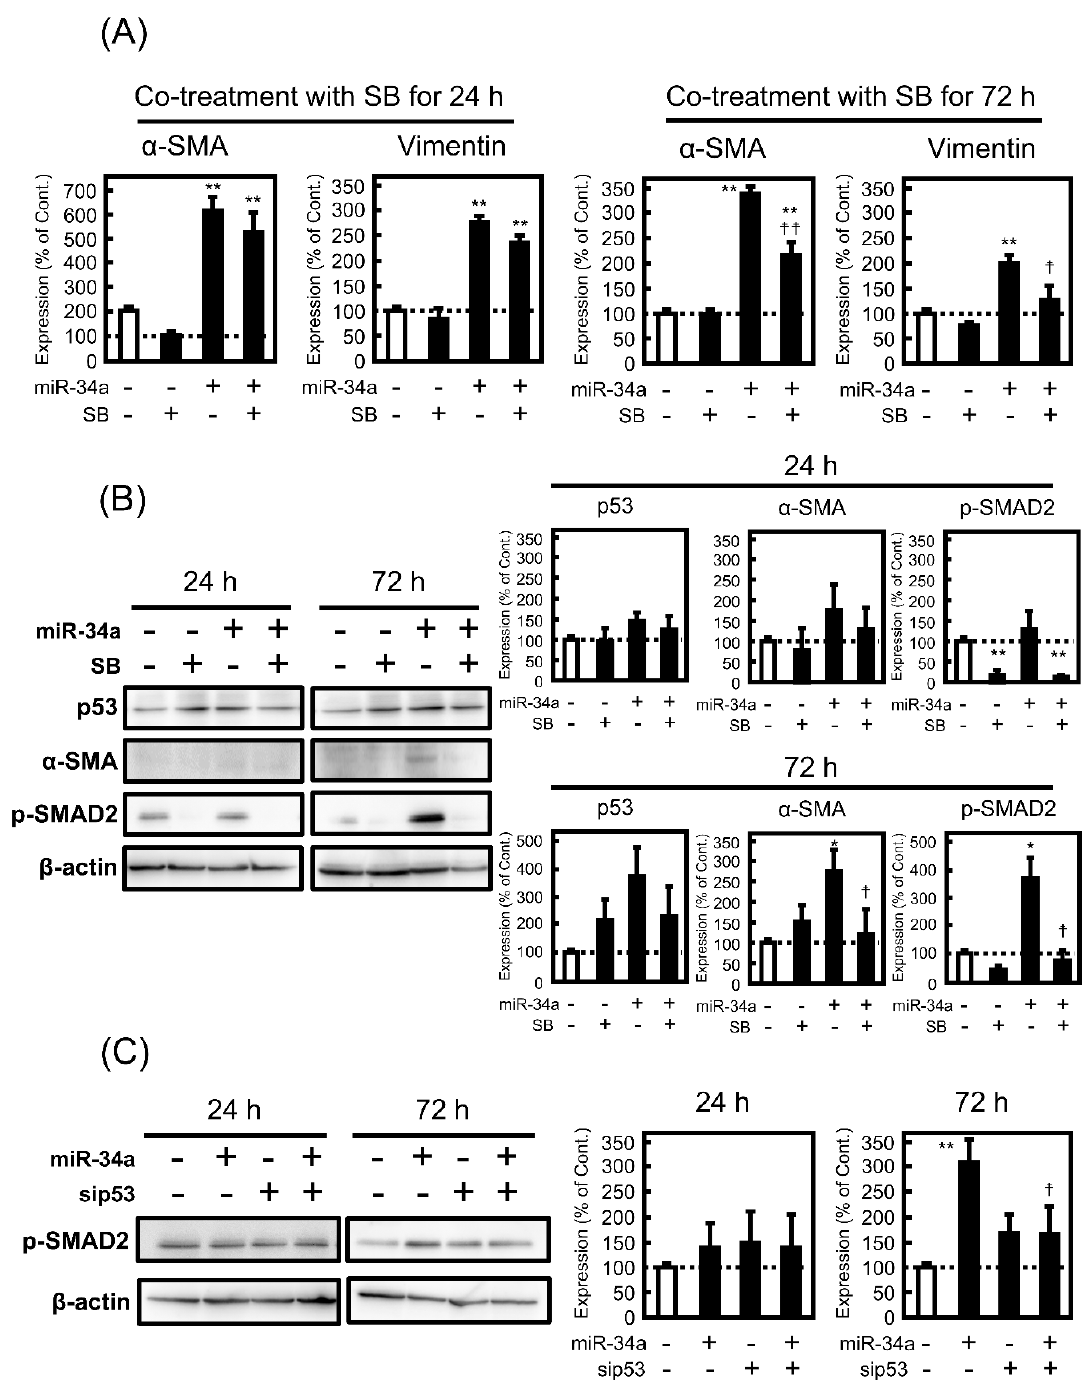
Figure 6. Role of the transforming growth factor (TGF)-β/SMAD signaling in miR-34a-induced changes in EMT-related phenotypes in A549 cells. The cells were transfected with NC (20 pmol/well) or miR-34a mimic (20 pmol/well) for 24 h. After removal of the medium containing the miRNA mimic, the cells were treated with or without 10 μM SB43142 (SB) for 24 or 72 h. ( A ) The mRNA expression levels of α-SMA were measured by real-time PCR. ( B ) Protein levels of α-SMA, p53, and p-SMAD2 were analyzed by Western blotting. ( C ) The cells were transfected with NC (20 pmol/well) or miR-34a mimic (20 pmol/well) under the control siRNA (siCont.; 10 pmol/well) or sip53 (10 pmol/well) for 24 h. After removal of the medium containing the miRNA mimic, the cells were treated with or without 10 μM SB43142 (SB) for 24 or 72 h. The protein levels of p-SMAD2 were analyzed by Western blotting. Each value represents the mean ± S.E.M. (n = 3). * p < 0.05, ** p < 0.01, significantly different from NC or NC under siCont. condition, †† p < 0.01, † p < 0.05, significantly different from miR-34a mimic or miR-34a mimic under siCont. condition.